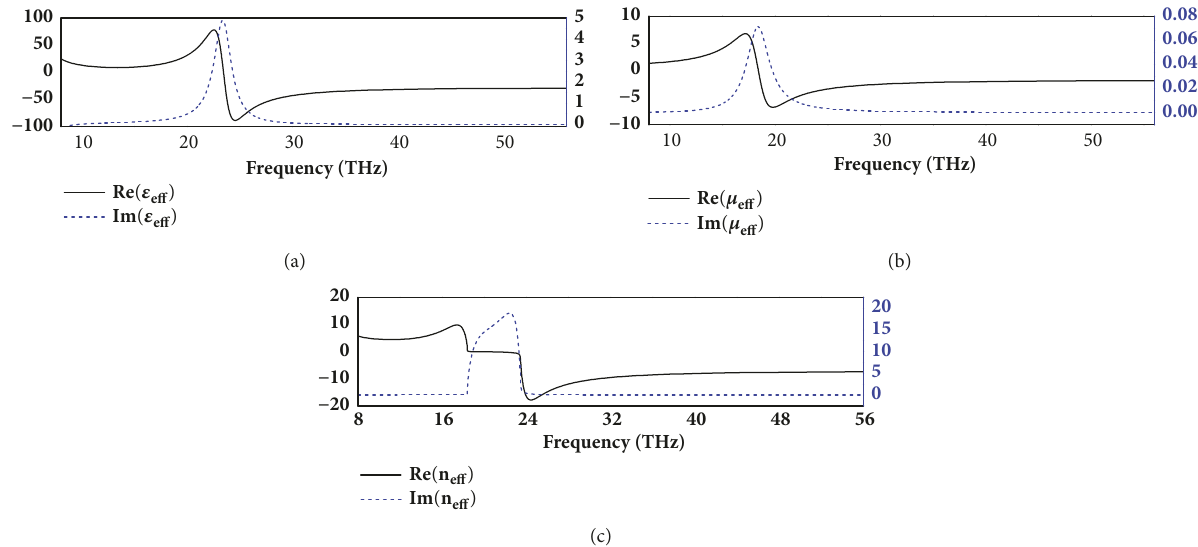
refractive-index point will become larger and larger as the radius of the dielectric sphere